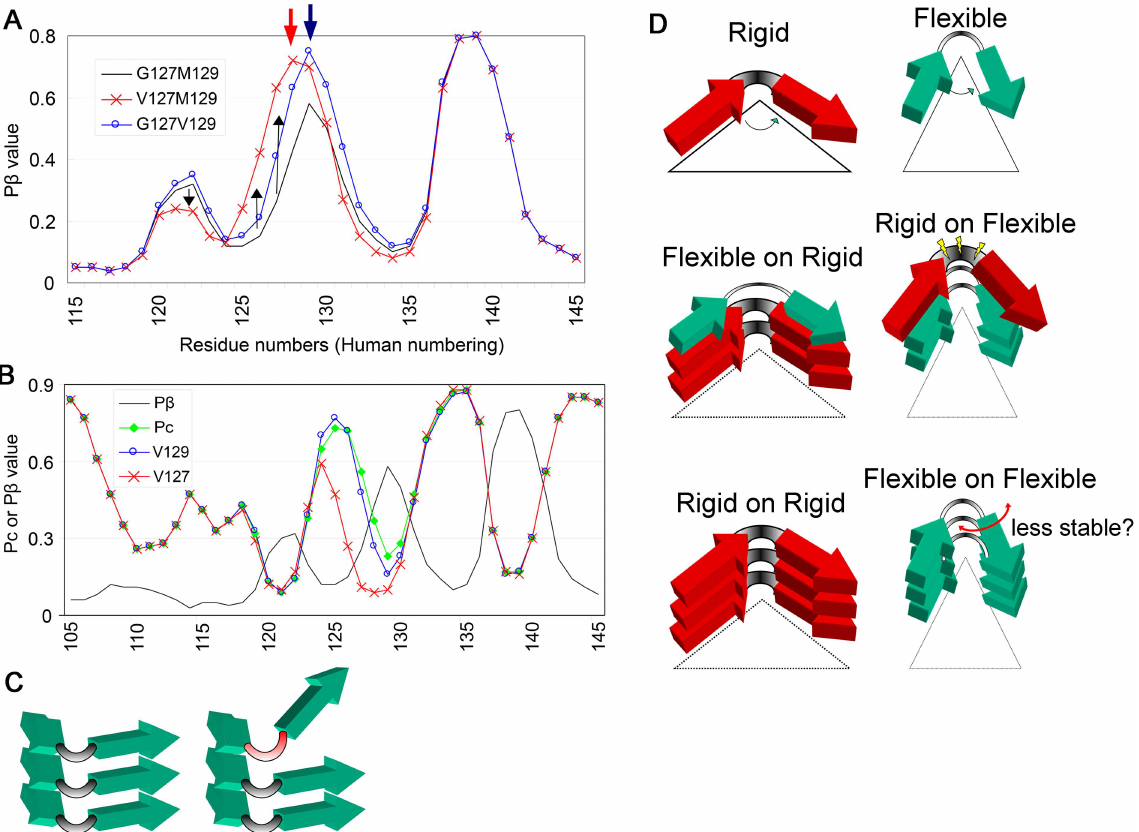
Fig 4. Positions of the β -strands and flexibility of the loop/kink region may affect cross-seeding efficiencies. A . Anti-prion effects of a polymorphism V127 may be attributable to alterationsin P β and Pc. Comparisonof P β graphsof human wild-typePrP (G127M129) with PrPs with the polymorphisms V127 (V127M129) or V129 (G127V129). The red and blue arrows indicate the crests of peaks of V127M129 and G127V129, respectively. Black arrows indicatedifferencesin P β values of V127M129from those of wild- type. B . Pc graphs of wild-typehumanPrP and PrPs with the polymorphisms V129 and V127. The gray curve representsthe P β graph of wild-typehumanPrP. C . Schematic illustrationof the possibleeffect of the loop/kinkregionon parallelin-register β -sheet formation. Differencesin the propertiesof loop/kinkregions,such as flexibility or length, would result in the inabilityof these peptides to form stable parallel-in-register β -sheets. D . Schematic illustrations of two types of β -loop- β motifs ( β -arch)with either a rigid (upper panels,red arrows, thick lines)or a flexible(green arrows; thin lines)loop. The middle panelsillustrate heterologous template- substrate conversionreactions: the left panel shows a reactionin which the template has rigid loop/kinkregions and the substrate has a flexibleloop, whereasthe right panel shows the opposite case. The bottom panelsillustrate homologous substrate-template conversionreactions.